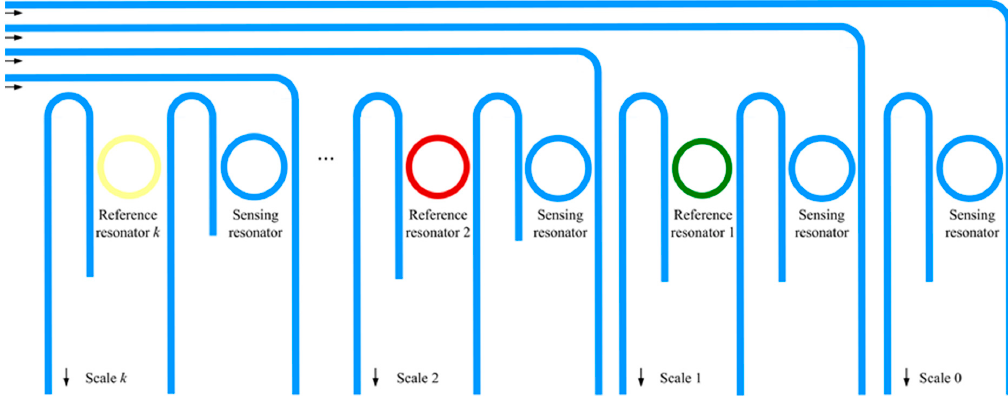
Figure 5. Layout of the sensor array with the multi-scale measurement.